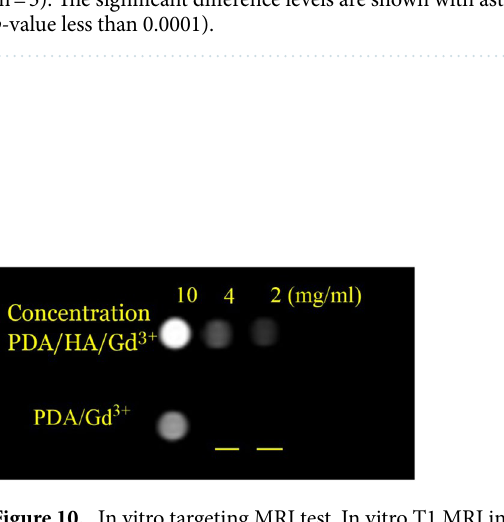
Figure 10. In vitro targeting MRI test. In vitro T1 MRI images of MDA-MB-231 cells treated with the PDA/ HA/Gd 3+ and PDA/Gd 3+